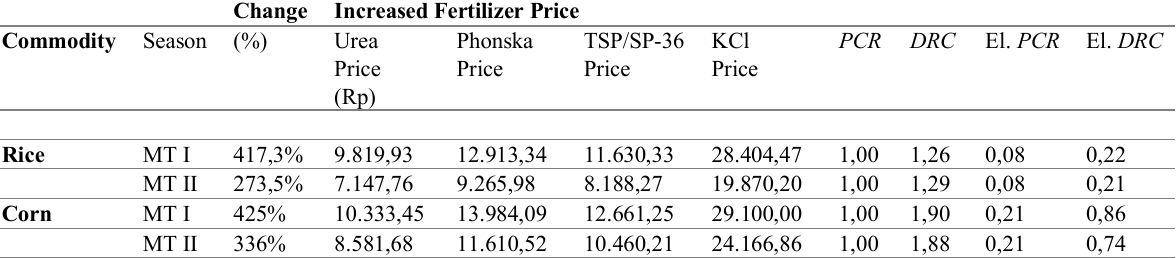
Table 7: Sensitivity Analysis of the Increase in FertilizerPrice